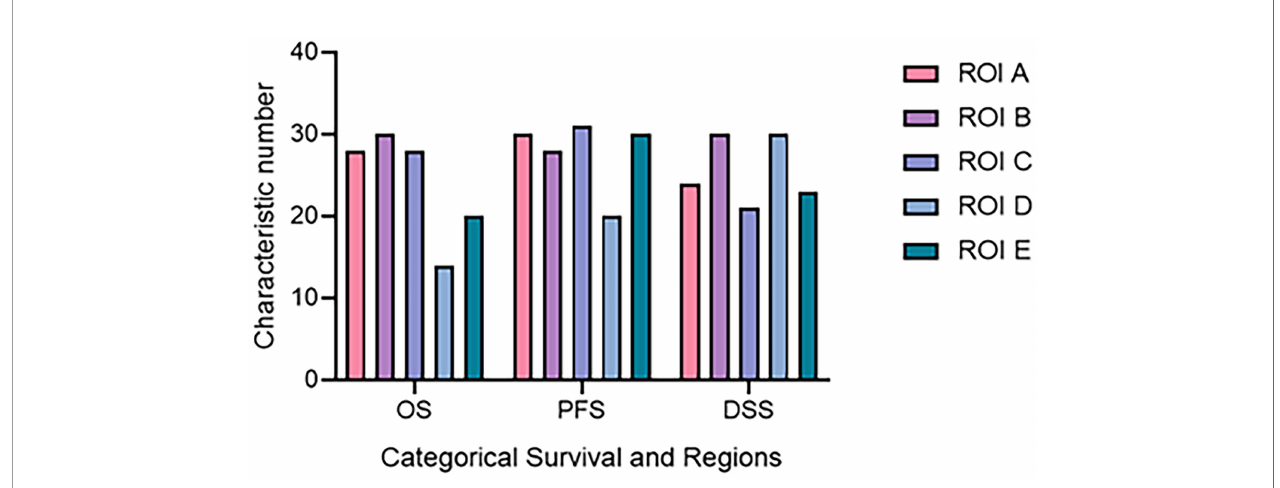
FIGURE 4 | The number of radiomics features corresponding to different ROI and survival time. DSS, disease-speci fi c survival; OS, overall survival; PFS, progression-free survival; ROI, region of